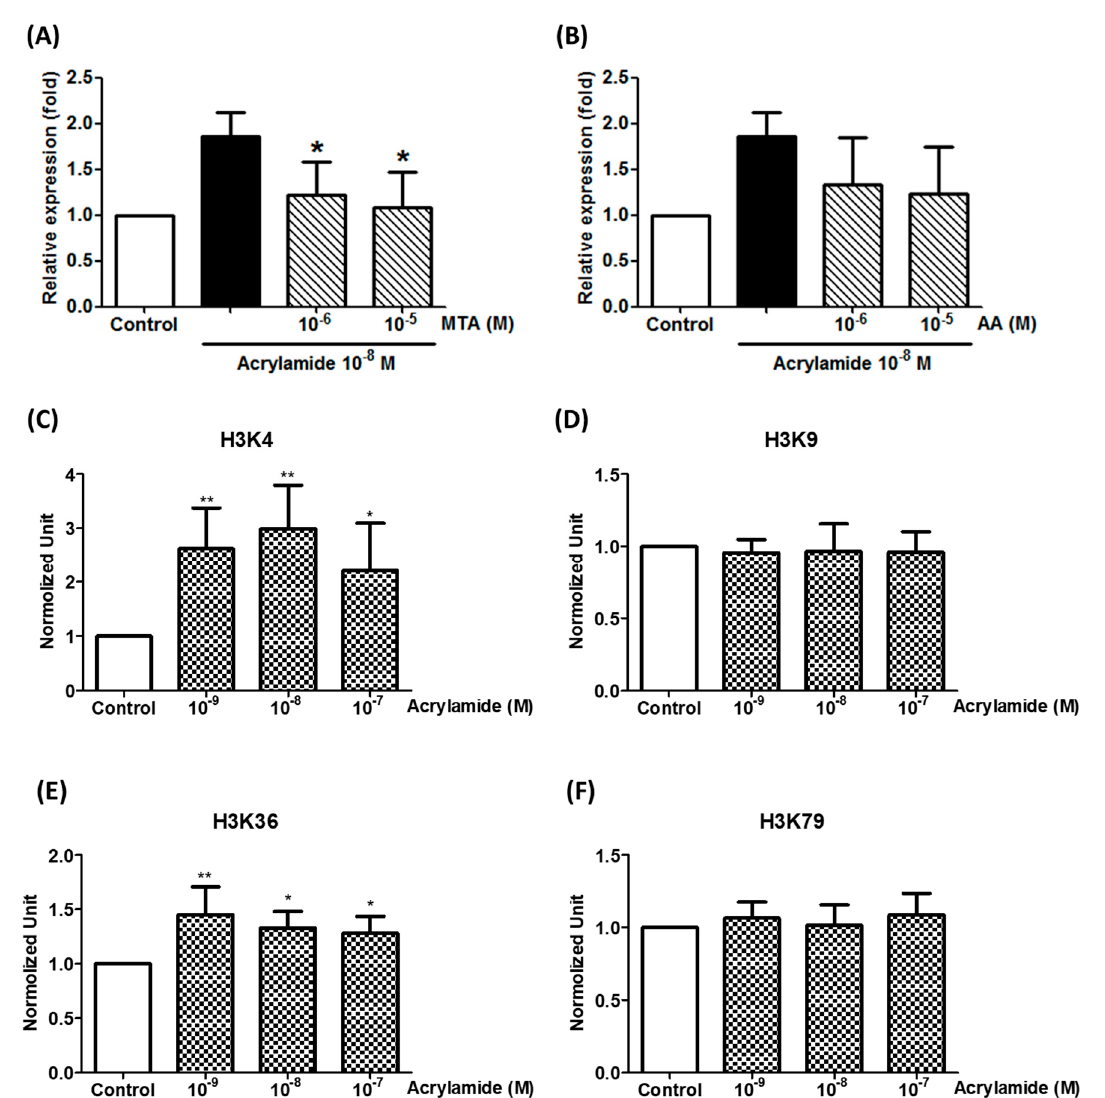
Figure 3. Acrylamide-induced SDHA expression regulated by histone trimethylation. ( A ) The expression of SHDA was detected by real-time PCR after acrylamide (10 − 8 M) and histone acetyltransferase inhibitor anacardic acid (AA) co-treatments (2 h). ( B ) The expression of SHDA was detected by real-time PCR after acrylamide (10 − 8 M) and histone methyltransferase inhibitor 5’-methylthioadenosine (MTA) co-treatments (2 h). * p < 0.05, ** p < 0.01, by the Kruskal-Wallis test; n = 6, means ± SD. ( C – F ) The effects of acrylamide on H3K4, H3K9, H3K36 and H3K79 trimethylation of the SHDA promoter was analyzed by ChIP assays. * p < 0.05, ** p < 0.01, by the Kruskal-Wallis test; n = 6, means ± SD.